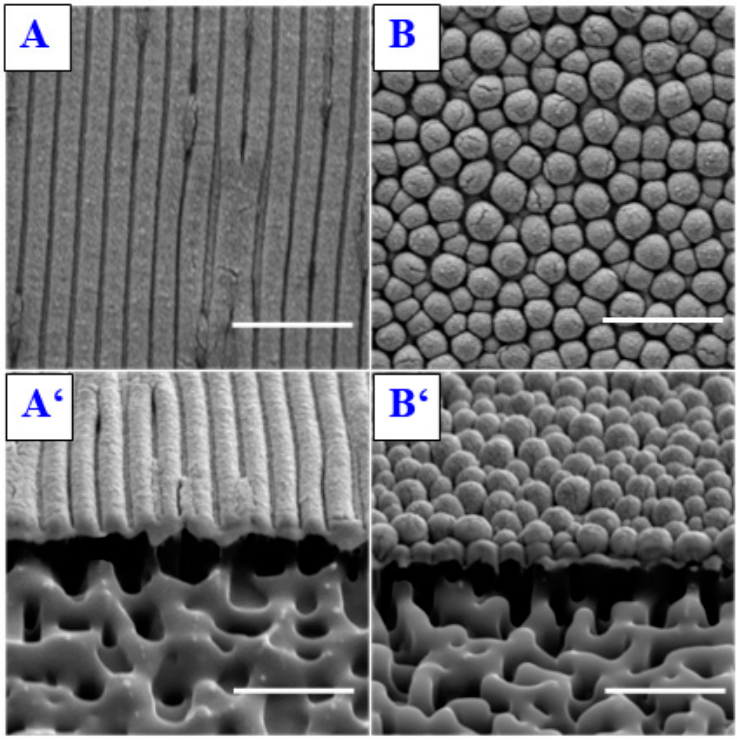
Figure 2. 2D SEM images of PES treated by 6000 pulses and laser fluence 8 of mJ/cm 2 ( A ); 16 mJ/cm 2 ( B ); bottom images ( A ̒ , B ̒ ) represent the FIB-SEM cuts of the same samples ( A , B , A ̒ , B ̒ —3 μ m × 3 μ m) [43].